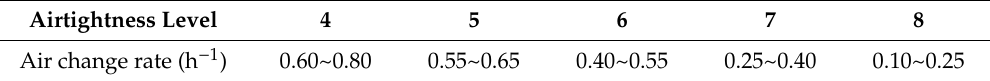
Table 5. Air change rates corresponding to di ff erent airtight external windows